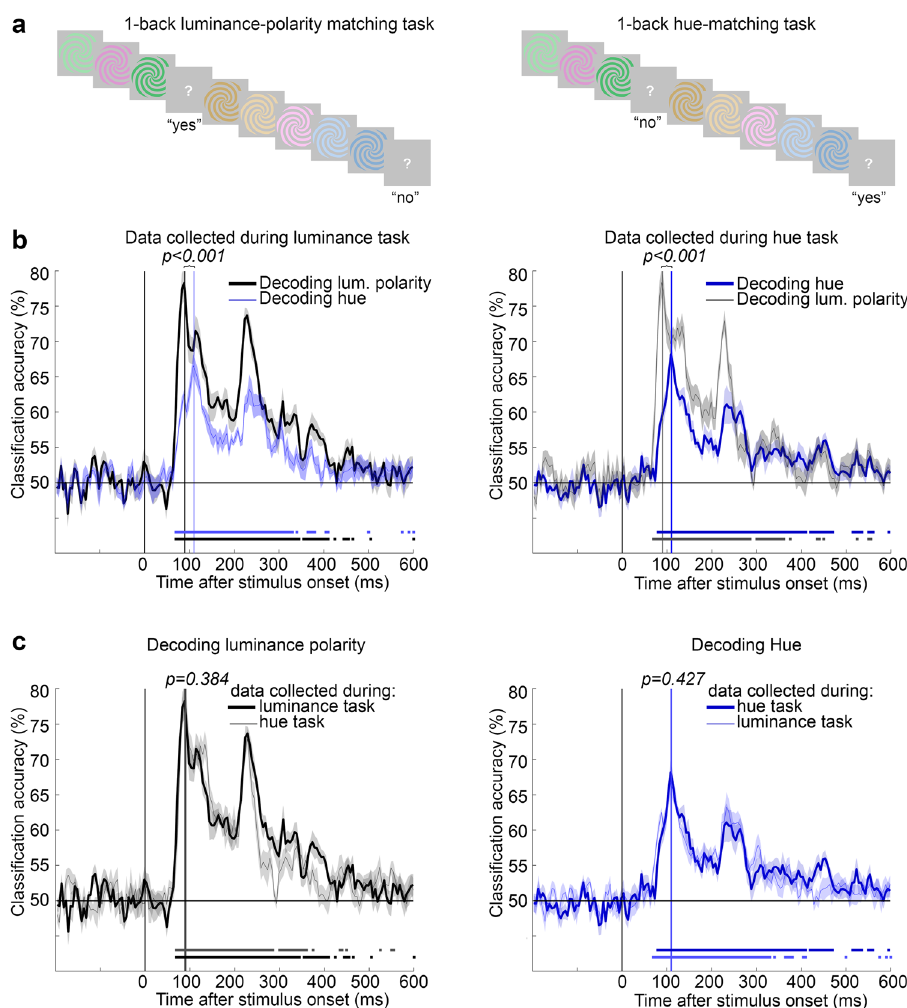
Fig. 5 Task had no impact on the time to peak decoding of hue or luminance polarity. a Tasks, 1-back luminance-polarity matching (left), 1-back hue matching task (right); note that the sequence of stimuli illustrated is the same for both tasks but the correct answers are different. b Left panel, Decoding luminance polarity (black trace) and hue (blue trace) using data from the luminance-polarity matching task. The data show the average of the identity decoding problems (see Fig. 1). Traces represent the average of 1000 bootstrapped time courses across eight sessions (two participants, four sessions each). Shading is SEM of the bootstrapped time courses. Vertical lines show the time to peak. The horizontal sequence of points above the x -axis show when decoding was greater than chance for four or more consecutive time bins (determined using within-subjects null decoding distribution and FDR corrected, see “ Methods ” section). Hue decoding peaked after luminance-polarity decoding ( p <0.001). Right panel, Decoding luminance polarity (black line) and hue (blue line) using data from the hue-matching task. Hue decoding peaked after luminance-polarity decoding ( p <0.001). Other conventions as for the left panel. c Left panel, Decoding luminance polarity using data from the luminance-polarity matching task (bold line) and the hue matching task (thin line). Shading represents the SEM. The time-to-peak for decoding luminance polarity identity was not impacted by task ( p = 0.384). Right panel, Decoding hue using data from the hue matching task (bold line) and luminance-polarity matching task (thin line); the time-to-peak for decoding hue was not impacted by task ( p = 0.427; p values re fl ect two-sided t -tests using a bootstrapping procedure, not adjusted for multiple comparisons). In all panels, the bolded traces show the decoding problems that align with the task. Luminance-polarity decoding was signi fi cant for a longer duration for data collected during the luminance-polarity matching task (left panel), while hue decoding was signi fi cant for a longer duration for data collected during the hue matching task (right